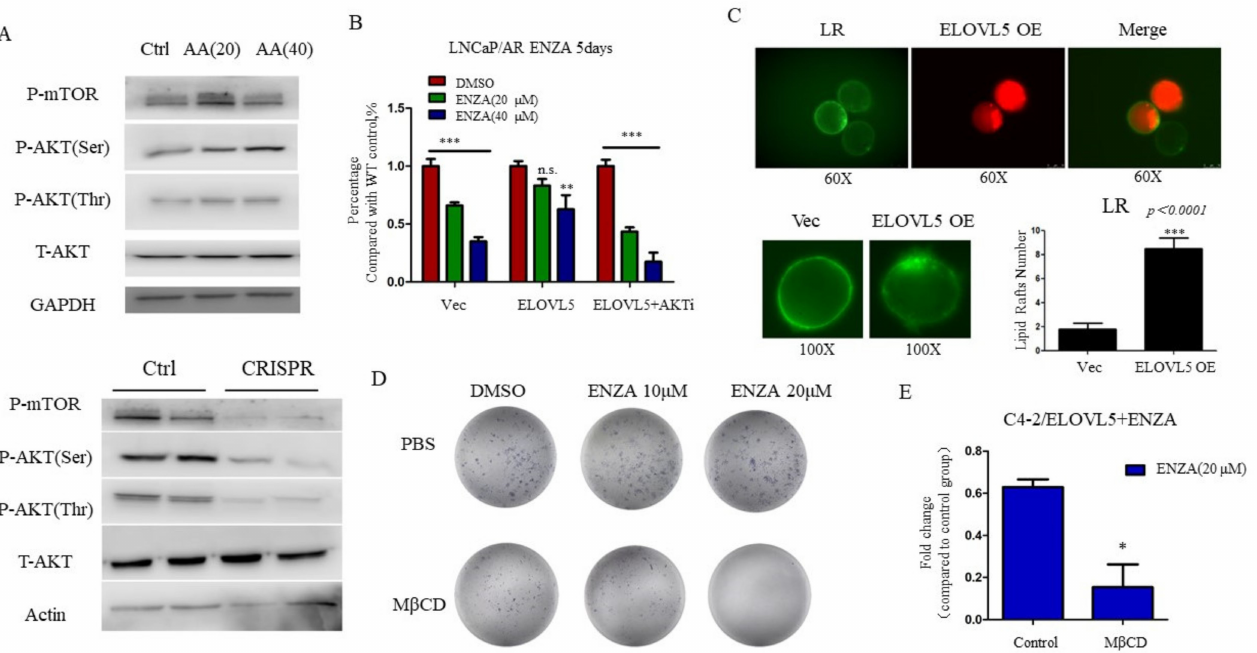
Figure 4. Lipid raft derived AKT-mTOR pathway mediates ELOVL5 induced enzalutamide resistance. ( A ). AKT-mTOR pathway is upregulated in AA treated C4-2 cells whereas is down-regulated in ELOVL5 KO C4-2 cells. Complete